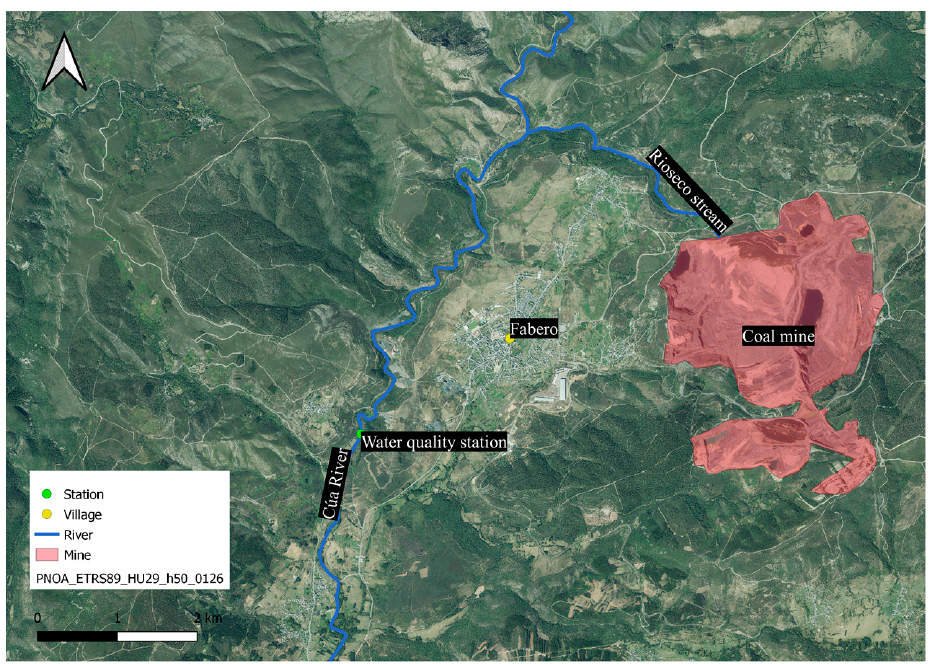
Figure 1. The geographical location of Fabero marked with a yellow dot, the coal mine in red, positioned to the east of Fabero, the water control station in green, and the two main rivers in the area: Cúa and Rioseco in blue.